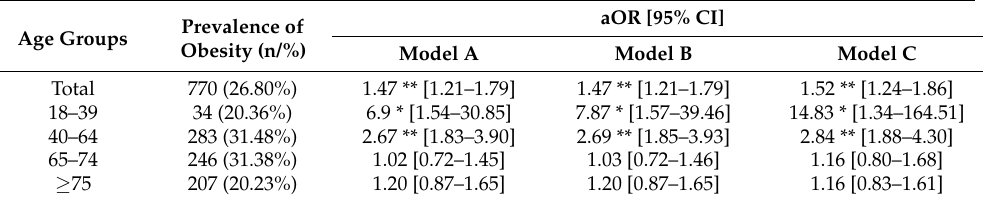
Table 3. Effect of obesity and overweight on death from COVID-19, broken down according to age